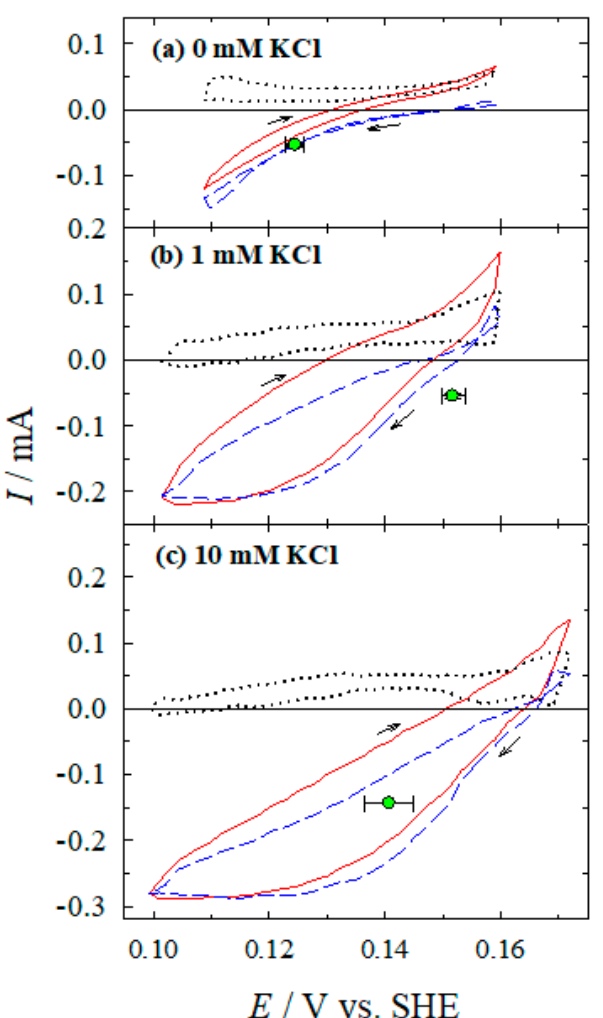
Figure 10. Dependences of the current (measured directly (solid line), calculated from EQCM data (dashed line), and their difference (dotted line)) on silver electrode potential in stationary solution. Solution composition (M): Ag 2 SO 4 —5 × 10 − 3 ; CoSO 4 —0.1; NH 3 —4.0; KCl: 0 ( a ), 10 − 3 ( b ), and 10 − 2 ( c ); pH 10.9; 20 °C. Potential sweep rate 2 mV s − 1 . ● —the rate of silver deposition under open-circuit conditions.